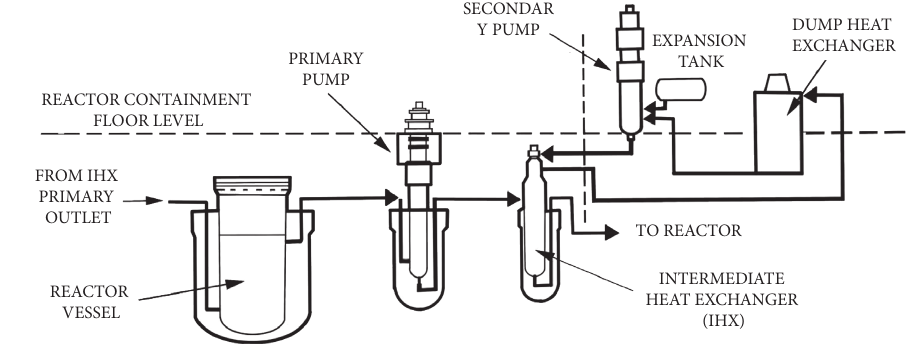
Figure 1: Overview of FFTF coolant system. Table 1: Initial conditions of FFTF LOFWOS test #13 [4].